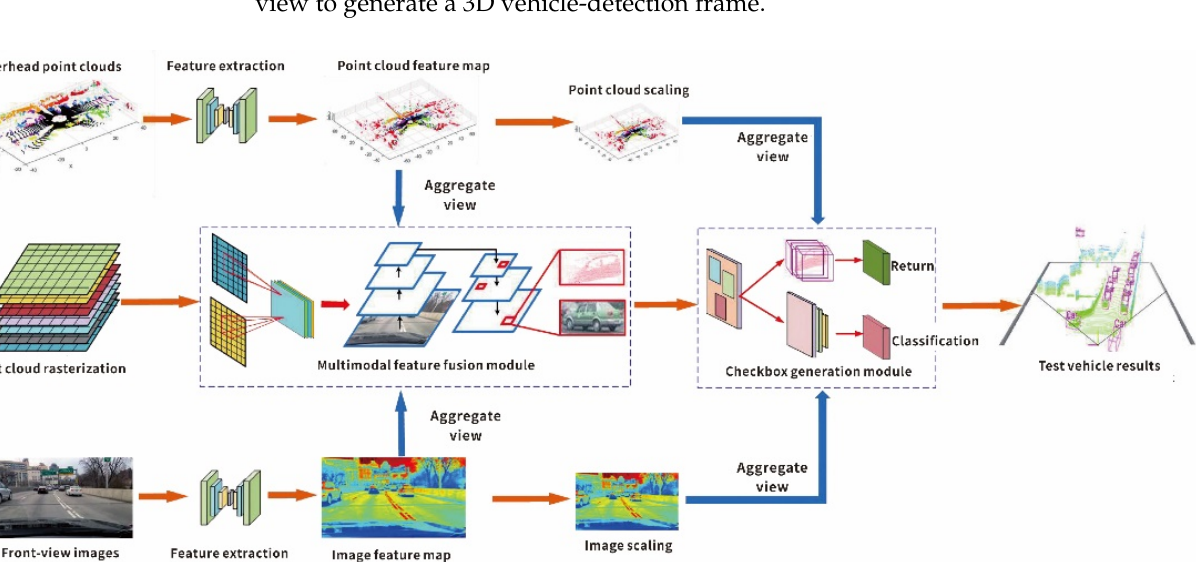
Figure 6. Point cloud data after filtering.